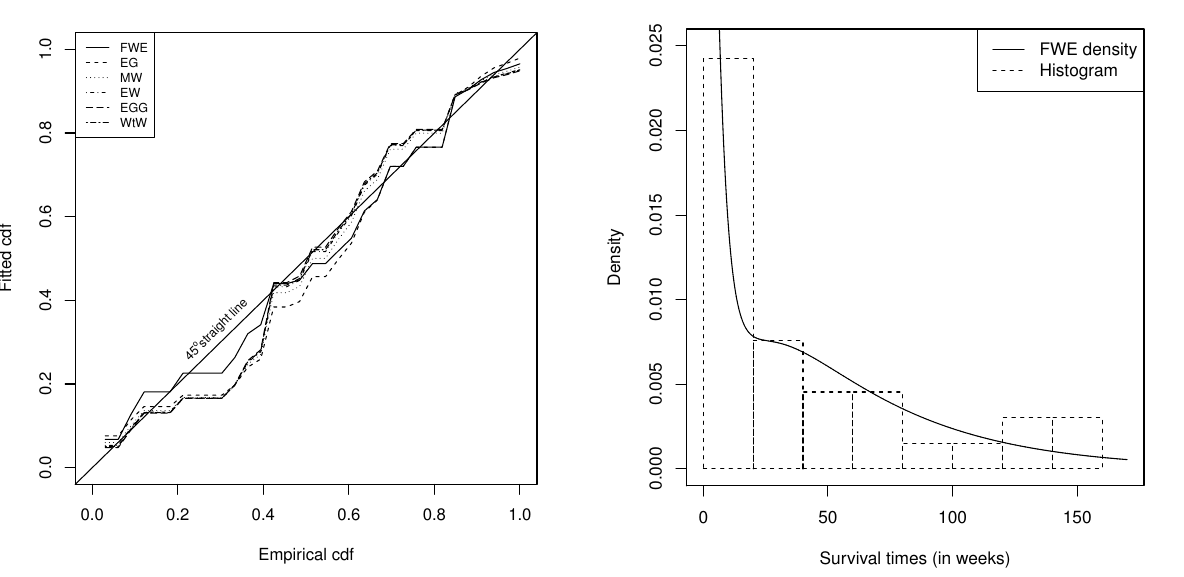
Figure 6. Probability-Probability (PP) plots of the distributions for survival times data.